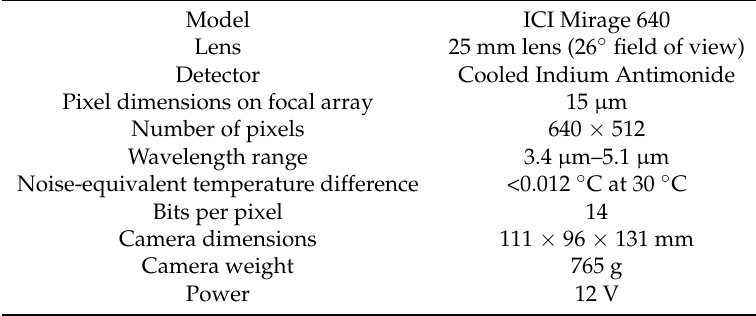
Table 1. Specifications of small Unmanned Aerial System (sUAS) thermal